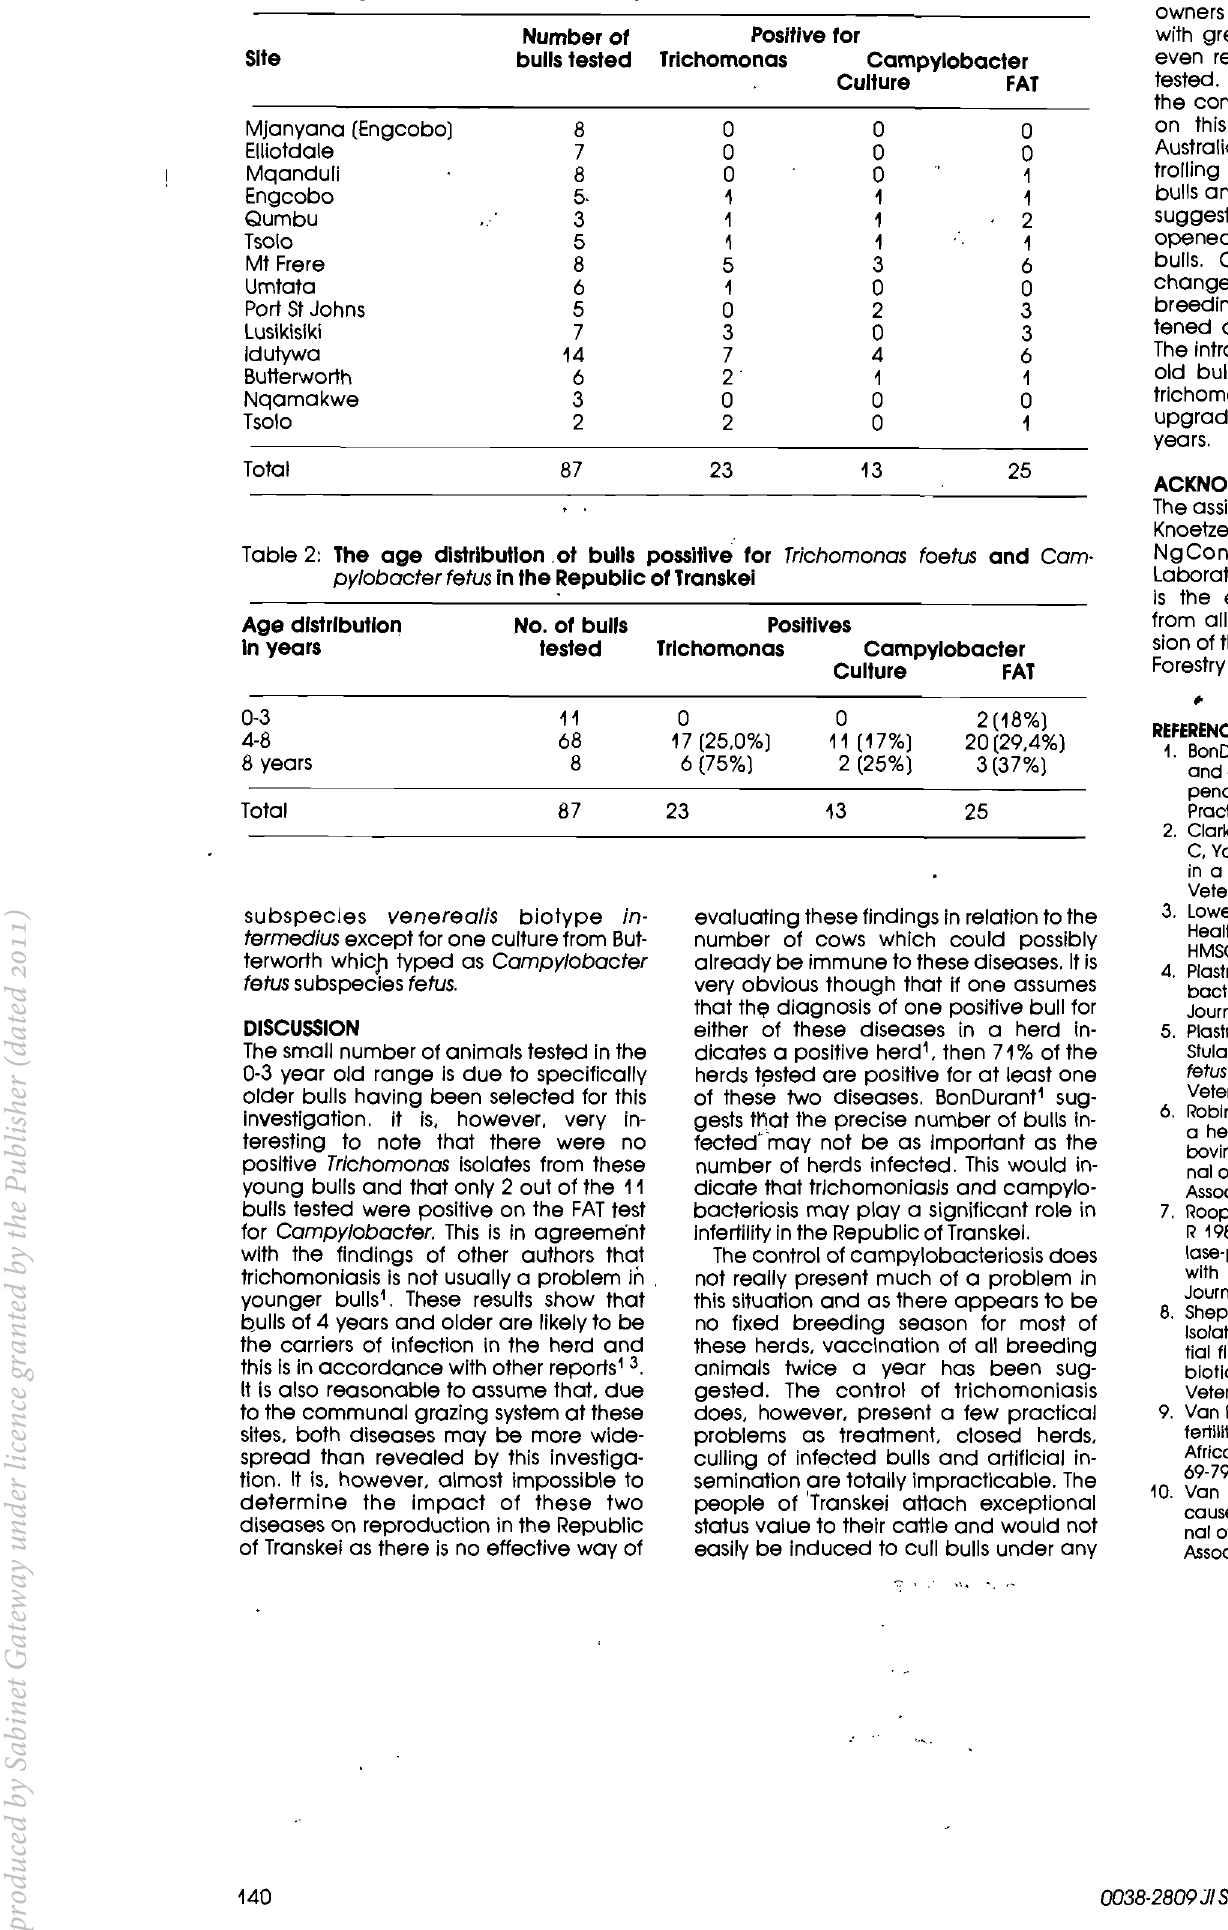
Table 2: The age distribution .ot bulls possitive tor Trichomonas foetus and Cam· py/obacter fetus in the Republic ot Transkei Age